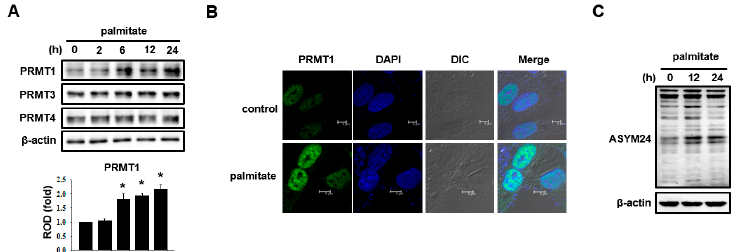
Figure 2. Protein arginine methyltransferase 1 (PRMT1) expression is increased in palmitate-treated mesangial cells. ( A ) Mesangial cells were treated with 30 μ M palmitate for various time intervals. Type I PRMT expressions were assayed by western blot analysis. The representative immunoblots were from at least three independent experiments. Data represent the means ± SEM of three independent experiments. * p < 0.05 vs. 0 h (ROD: relative optical density); ( B ) mesangial cells were treated with 30 μ M palmitate for 24 h. The cells were labeled with anti-PRMT1 and a fluorescein isothiocyanate (FITC)-conjugated secondary antibody. Nuclei were stained with 4 ′ ,6-diamidino-2-phenylindole (DAPI) and observed under a confocal microscope. The representative images were from at least three independent experiments (scale bar: 5 μ m); ( C ) mesangial cells were treated with 30 μ M palmitate for 12 h and 24 h. Cell extracts were subjected to western blot analysis with ASYM24 antibody. Representative immunoblots were from at least three independent experiments.